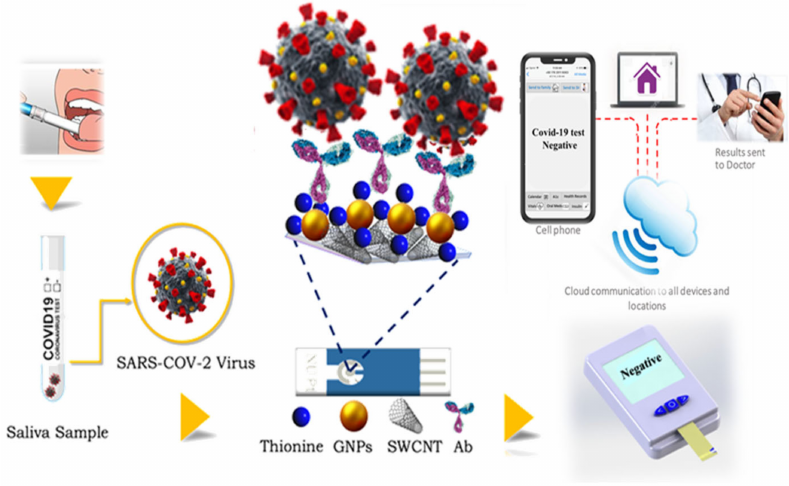
Figure 3. Salivary sensing system for COVID-19